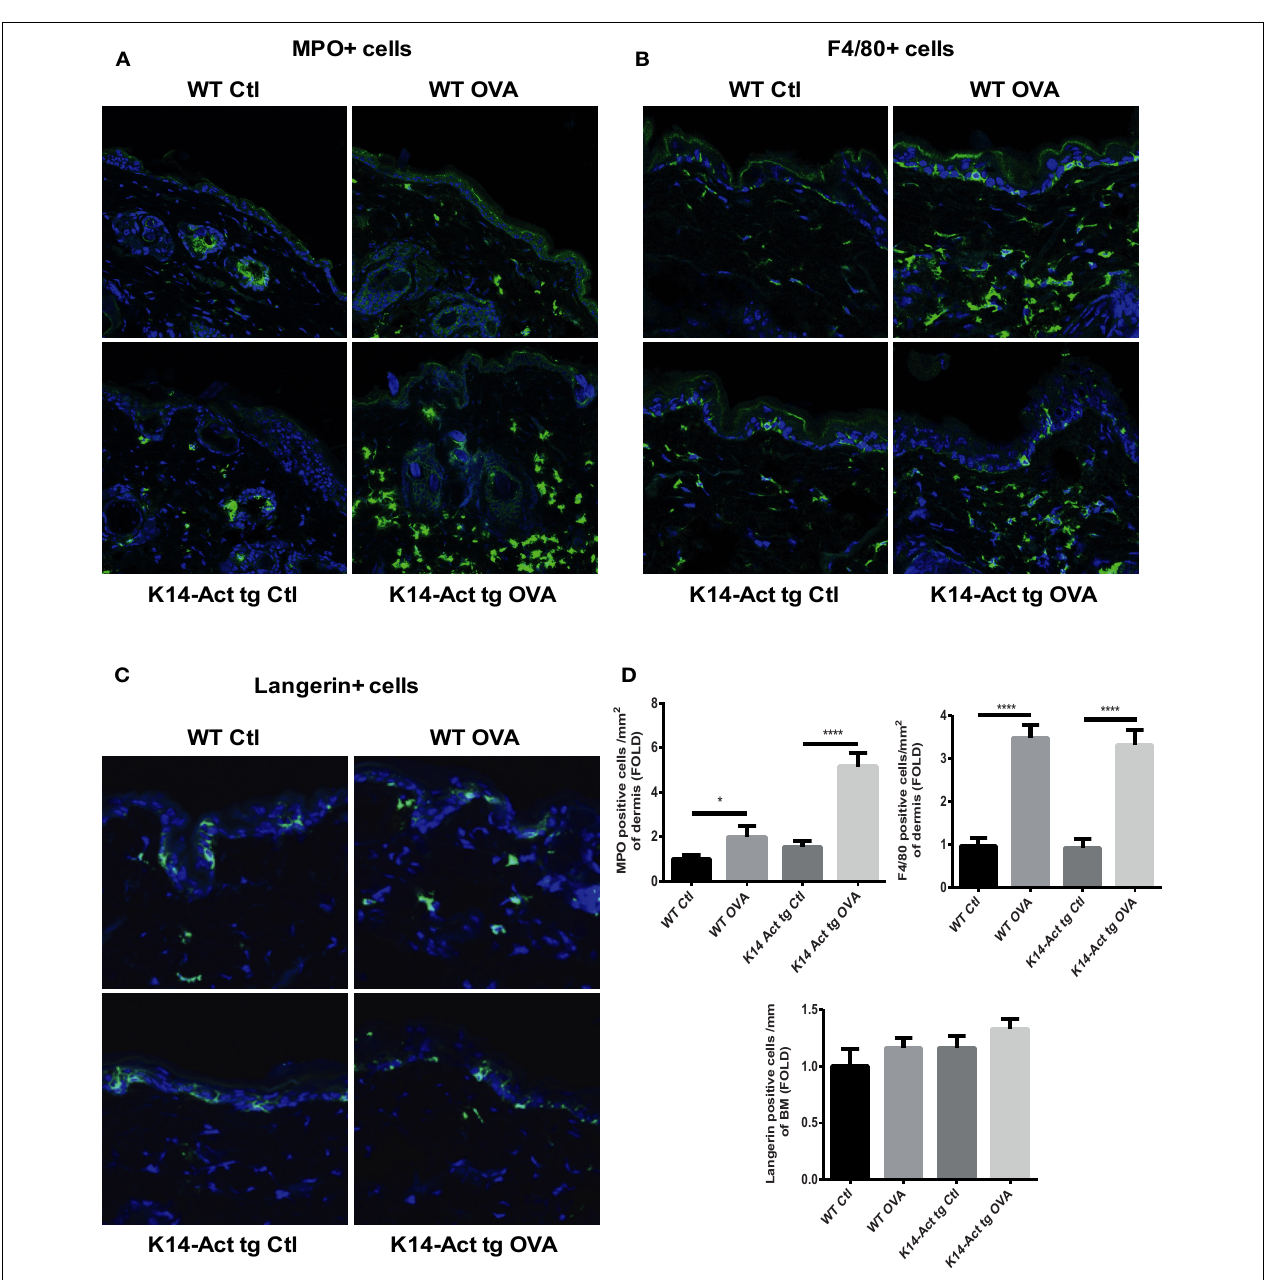
FIGURE 2 | Morphological and cell analysis of vehicle-treated and OVA-treated mice . Cryosections from the four experimental groups were obtained. MPO + (A) , F4/80 + (B) , and langherin + cells (C) were labeled with the respective antibodies, and analyzed with a confocal microscope (20 × objective). (D) MPO, F4/80, or langerin-positive cells were quantified and statistic analysis was performed with the Mann–Whitney U -test ( p < 0.05* and p <